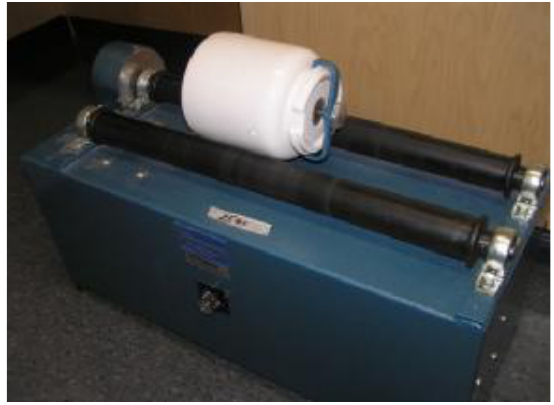
Fig. 1. A porcelain ball mill used for milling and mixing.